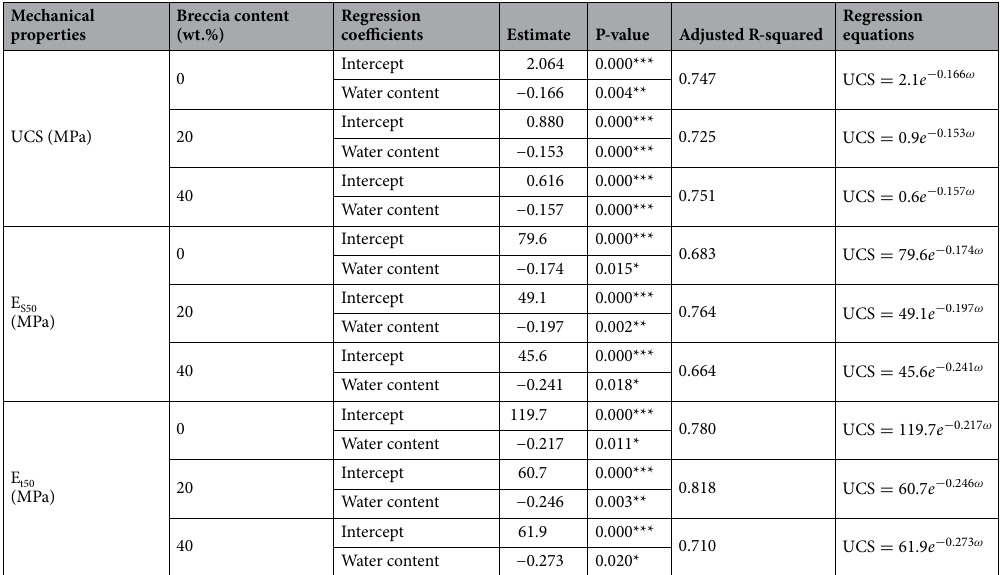
Table 8. Correlations between water content and mechanical properties (UCS, E s50 , and E t50 ) for breccia contents of 0, 20, and 40 wt.%. R 2 is the coefficient of determination, and ω is water content (Δ%). ※ P-value: